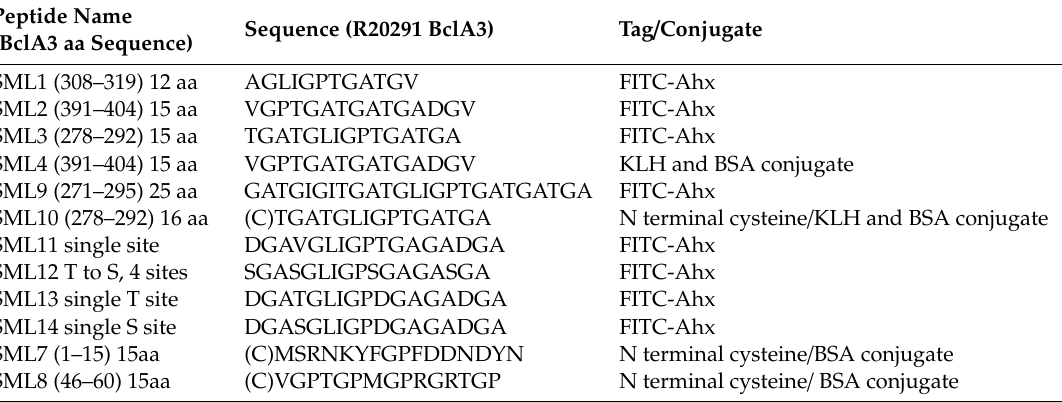
Table 1. Synthetic BclA3